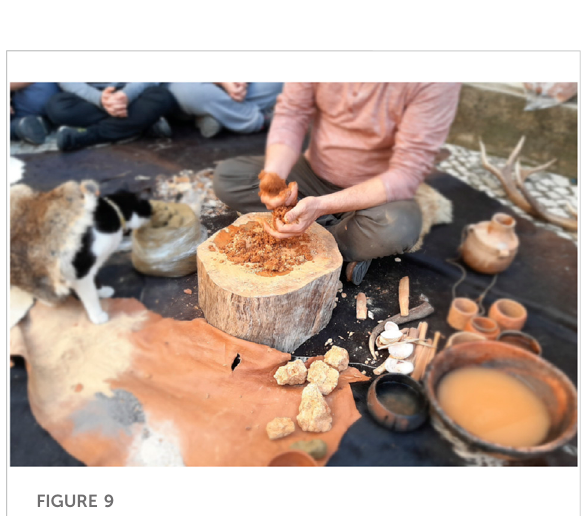
FIGURE 8 Tool production.